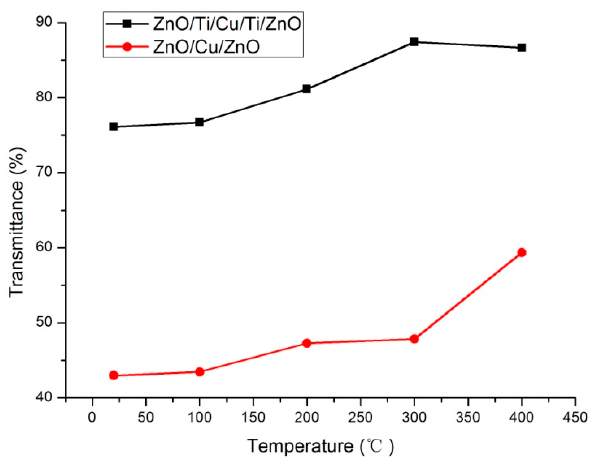
Figure 6. Optical transmission spectra of the ZnO(Ti/Cu) film system with varying annealing temperatures.